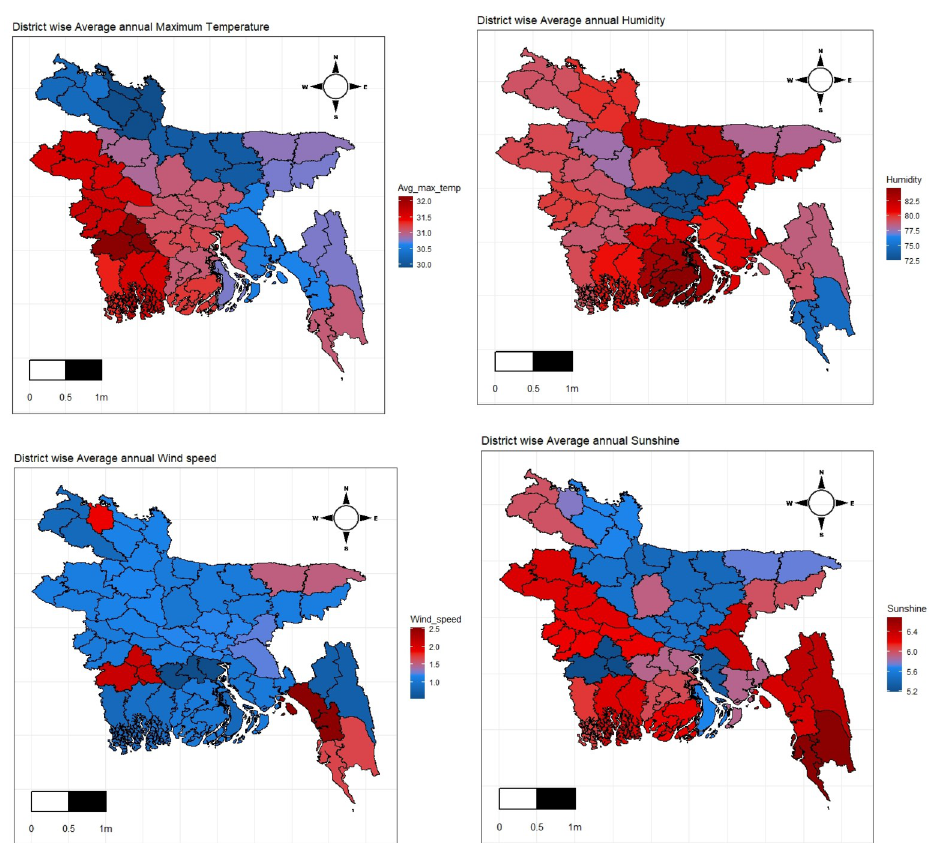
Fig 3. District wise variation of climate variables (a) maximum temperature, (b) humidity, (c) wind speed, and (d)